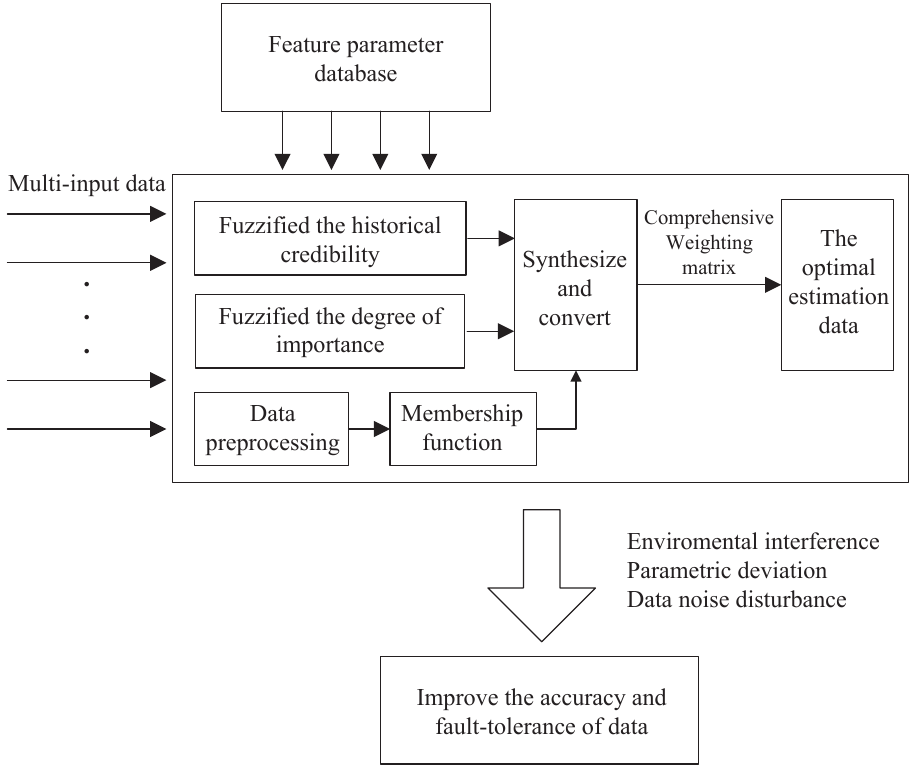
Figure 4. The architecture of the improved onboard safety computer